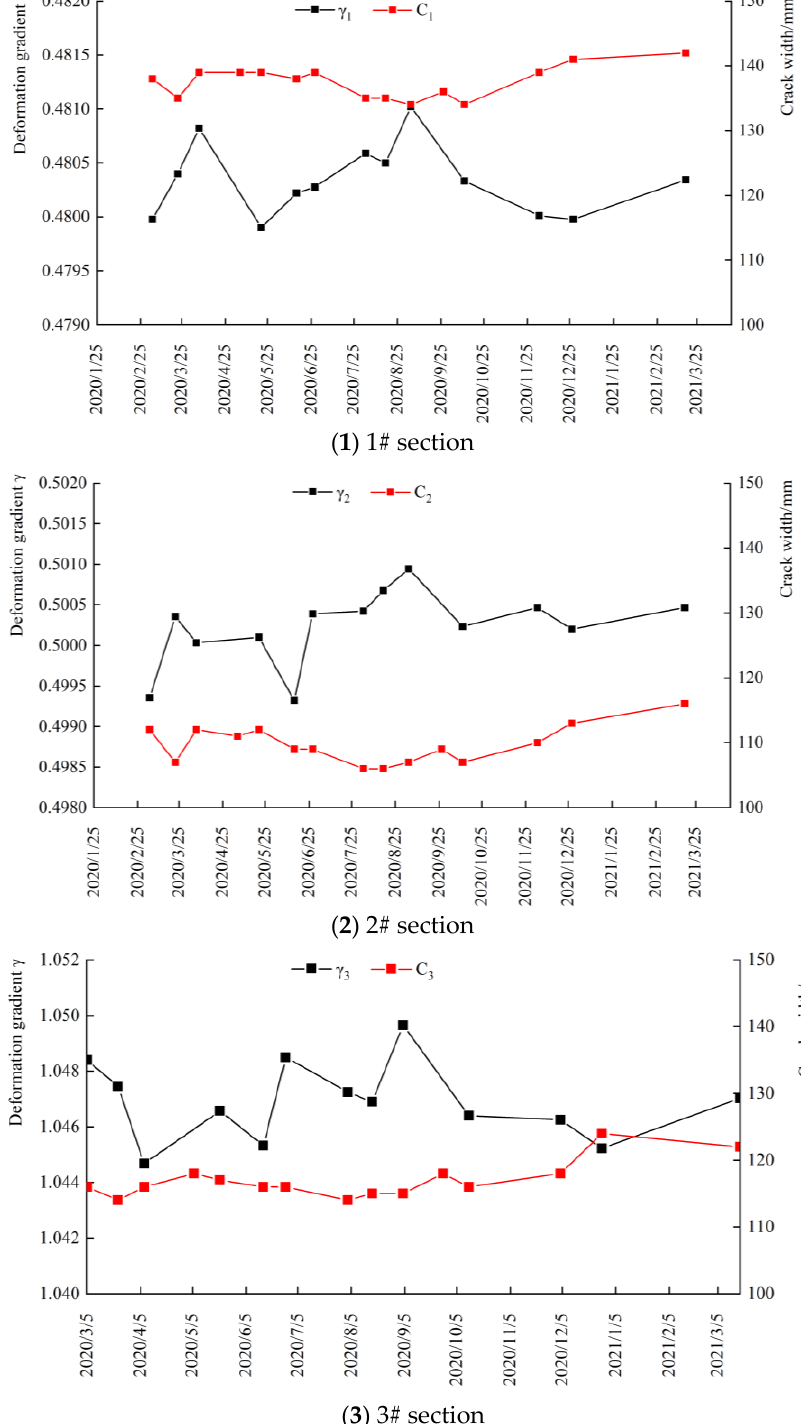
Figure 16. Time history curve of crack width and deformation gradient.